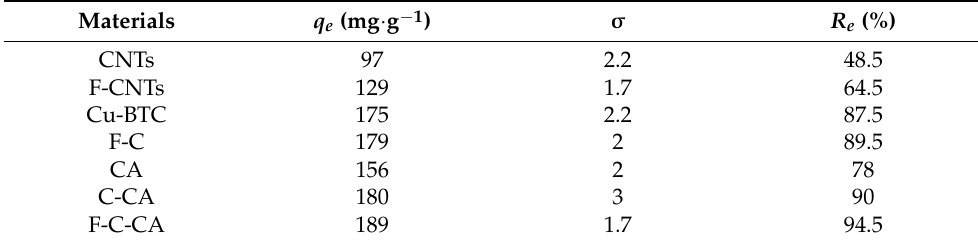
Table 2. Comparison of adsorption properties of different